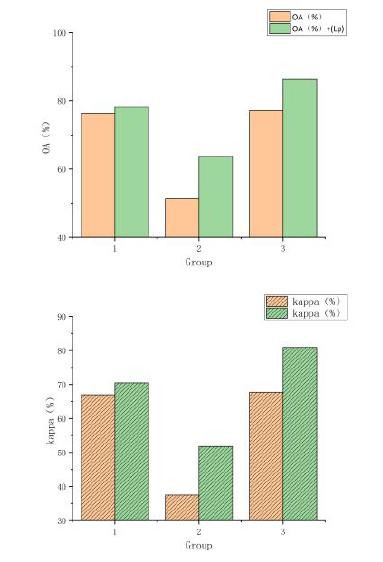
Figure 4. The OA and kappa with and without 𝐿 𝑝 .